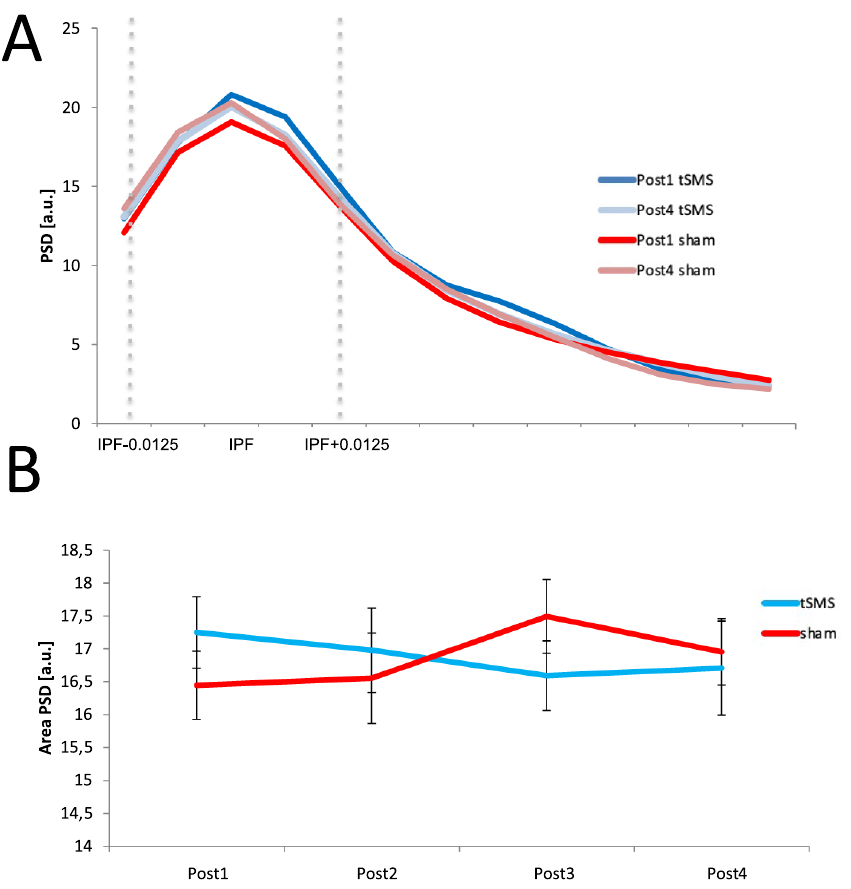
Figure 4. Focal resting state frequency domain power analysis. ( A ) Power spectrum density (PSD) average aligned to the individual peak frequency (IPF) calculated on the left-M1 seed of the BOLD signal extracted from resting state fMRI time series in the sham and real group during Post1 and Post4. ( B ) Time course of the area below the curve of PSD within the frequency range of the IPF ± 0.0125 Hz in the sham and real groups. Error bars depict standard error of the mean (SEM). a.u. arbitrary